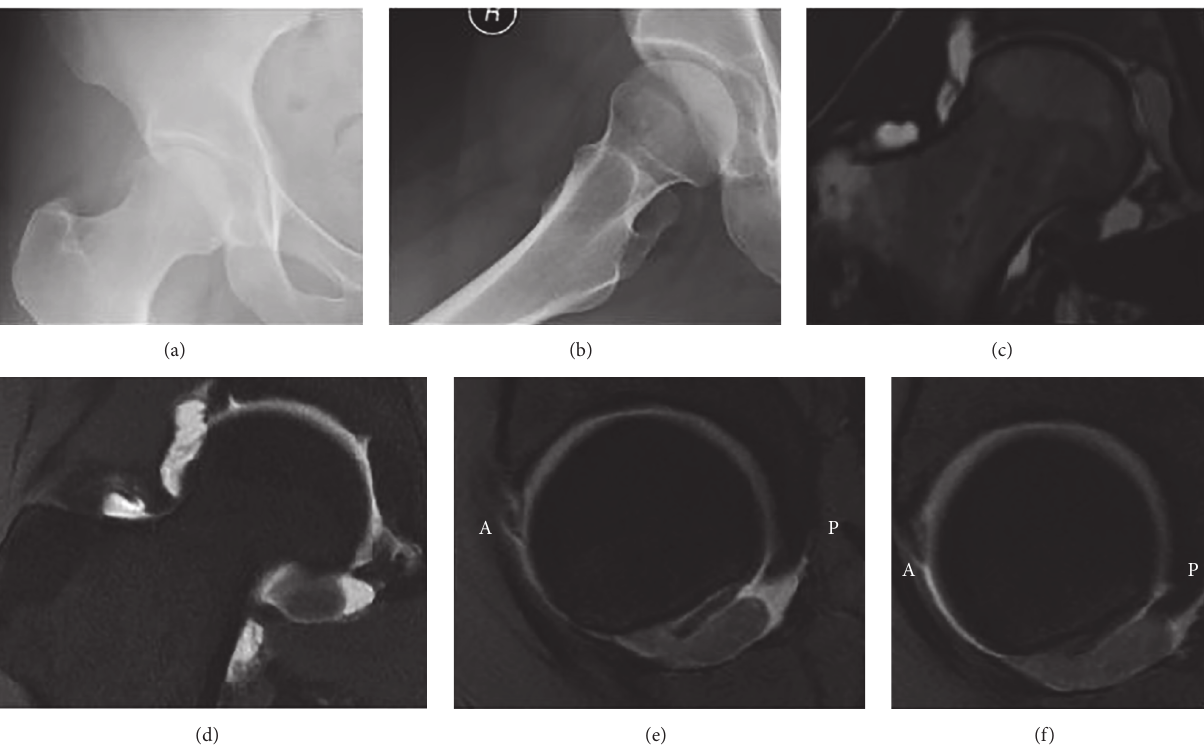
Figure 1: Preoperative anteroposterior (a) and frog-leg radiographs (b) of the right hip in Case 1 demonstrate developmental dysplasia of the hip and the presence of a cross-over sign. Preoperative coronal FIESTA 3D (c), coronal T1-weighted fat-saturated (d), and sagittal proton- density fat-saturated (e, f) magnetic resonance sequences with intra-articular contrast reveal the tumor, a 2.5 cm intermediate to low signal focus within the inferomedial aspect of the right hip joint, in addition to a complex tear of the right anterior and anterosuperior acetabular labrum. A = anterior; P = posterior.